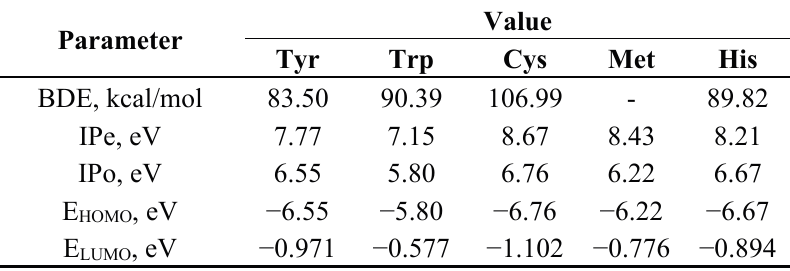
Table 6. Thermodynamic and energy parameters of redox-active amino acids in gas phase (298